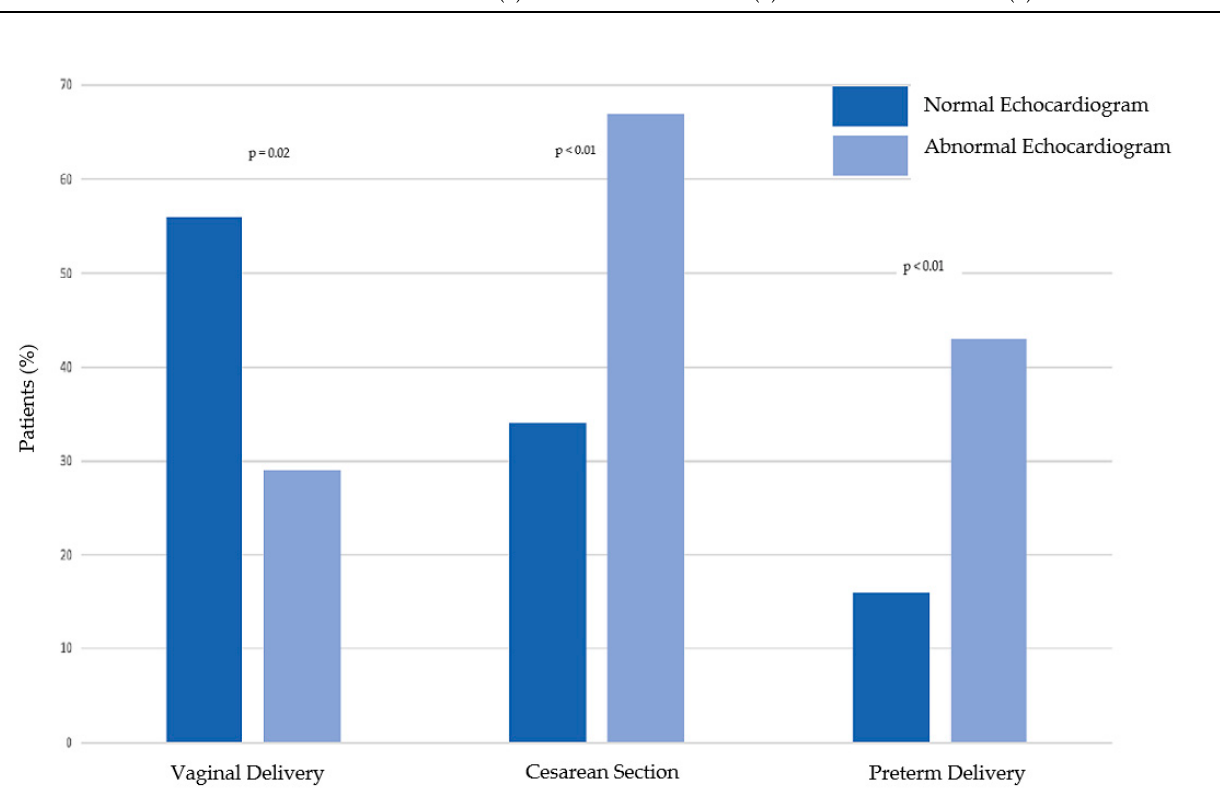
Figure 2. Obestetric outcomes among low-risk pregnant women who undergo echocardiography.